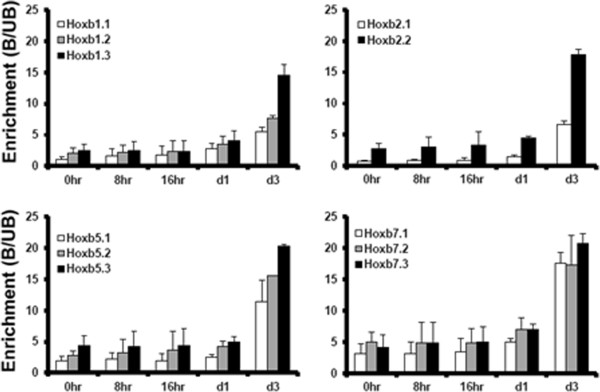
Treatment of differentiating embryonic stem cells with retinoic acid increases H3K9ac at Hoxb genes. Chromatin immunoprecipitation-quantitative PCR (ChIP-qPCR) was used to investigate H3K9ac levels at two or three regions across four Hoxb genes, as indicated, in differentiating embryonic stem (ES) cells (CCE/R) before and after treatment with retinoic acid (RA). Leukaemia inhibitory factor (LIF) was removed at d0 (0 h) and RA added at d2. Location of the primer pairs used is shown in Figure 5B. Data are displayed as the enrichment of the Hoxb sequences in the bound relative to the unbound (B/UB) sample for each timepoint. Error bars represent the standard error of the mean of independent experiments (n = 2).